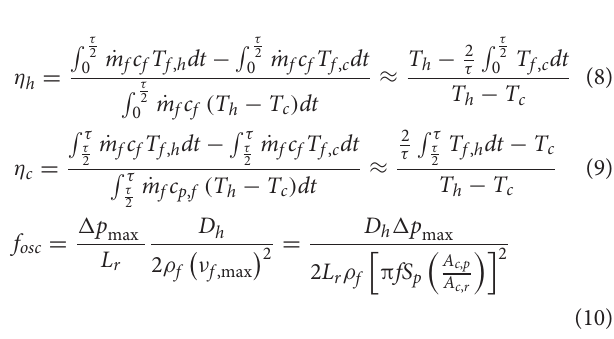
FIGURE 3 | Time evolution of (A) the fluid mass flow rate in passive rig and (B) the synchronized magnetic field and fluid mass flow rate in active test machine during the different steps of over one magnetic cycle. Since the passive rig and AMR test machine run at different frequencies, the amplitudes of fluid mass flow rate are significantly different between passive and active